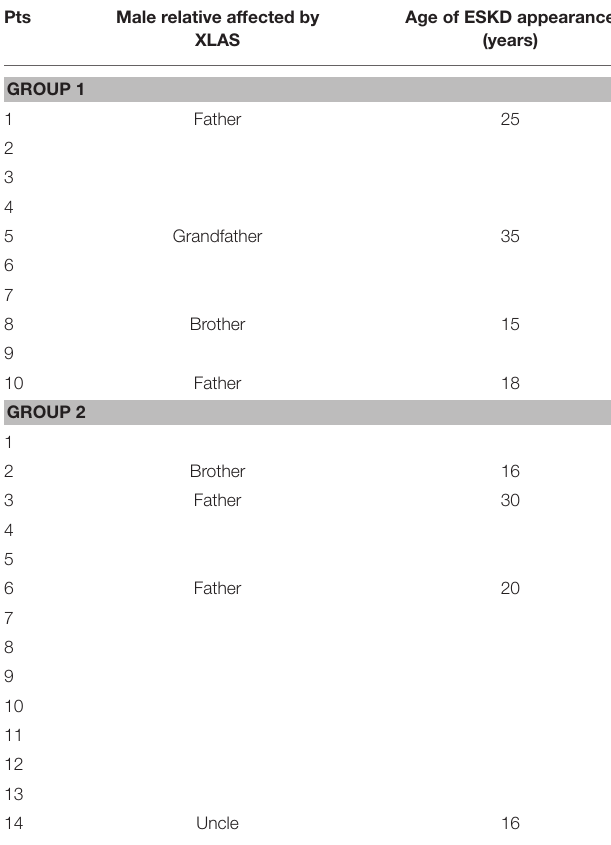
TABLE 3 | Age of ESKD appearance in male relatives of our patients. Pts Male relative affected by